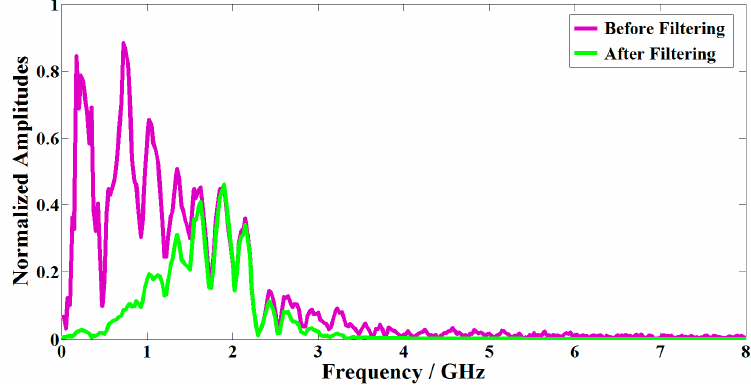
Figure 3. The frequency spectrum before ( purple ) and after ( green ) the band-pass filtering.